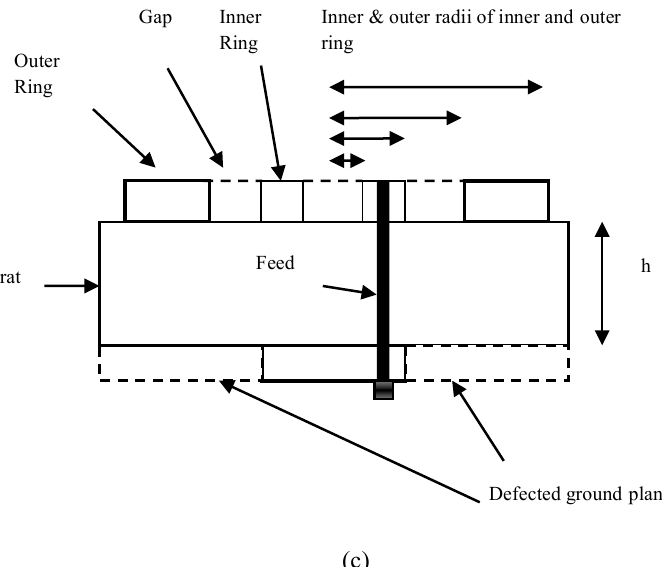
Figure 1. Geometry of Multiple ring gap coupled DGS microstrip antenna design (a) top view (b) bottom view (c) side view.